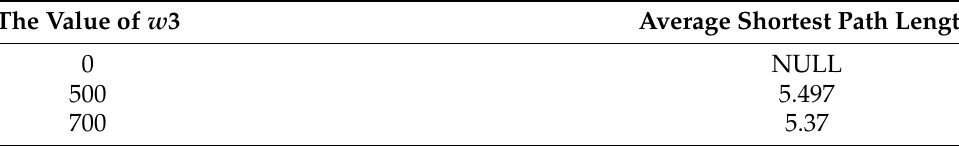
Table 1. The change of average shortest path length with w 3 in the